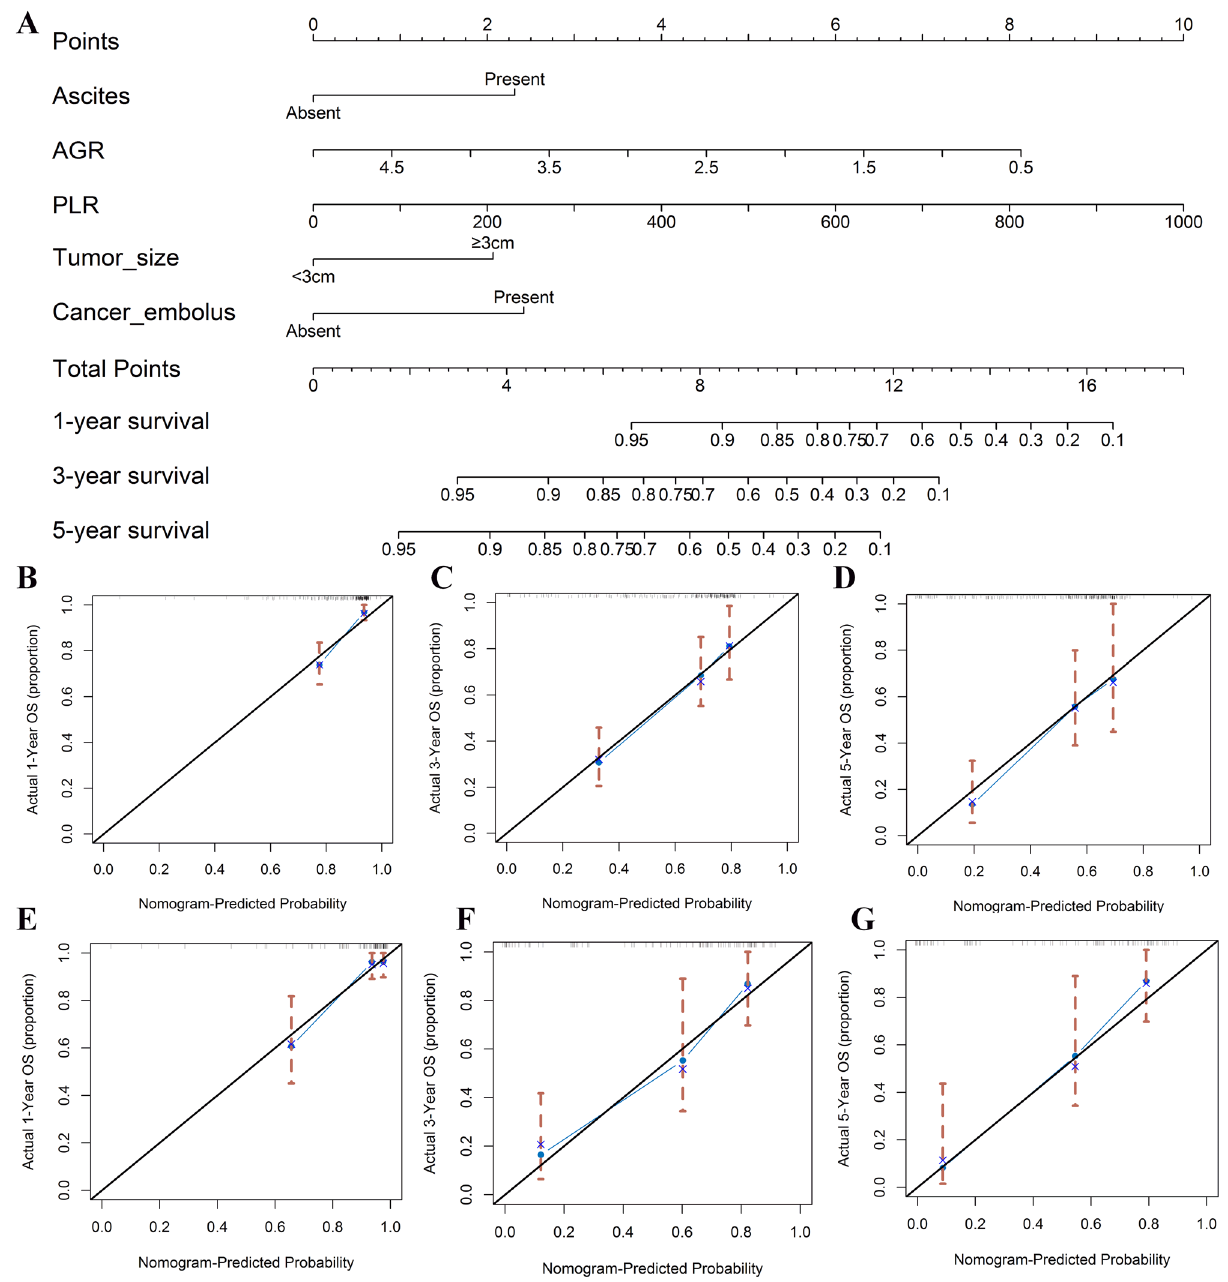
Figure 4. Nomogram for predicting 1-, 3-, and 5-year OS among HCC patients undergoing microwave ablation in the training cohort. The black line represents the “ideal” line of a perfect match between predicted and observed survival. The blue line indicates the performance of the proposed nomogram. The X-axis is nomogram predicted probability of survival and Y-axis is actual survival. Blue dots are sub-cohorts of the data set; red vertical bars represent 95% confidence interval (A) . Calibration curves of the nomogram for predicting 1- (B) , 3- (C) , and 5-year survival (D) in the training cohort. Calibration curves of the nomogram for predicting 1-year (E) , 3-year (F) , and 5-year survival (G) in the validation cohort. The figure was performed using R software (version 3.3.1, Vienna, Austria, https:// www.r- proje ct. training and validation cohorts. Results showed the constructed nomogram showed clearly different prognostic strata in the training and validation cohorts, which confirmed the discriminatory accuracy of the constructed nomogram. According to the nomogram, we can assess the risk of early death of HCC after surgery and conduct early individualized interventions including early postoperative trans arterial chemoembolization (TACE) or postoperative immunoregulatory therapy for high-risk patients. The comparisons of predictive power between our nomograms and the conventional BCLC staging system as well as simple tumor size showed that the